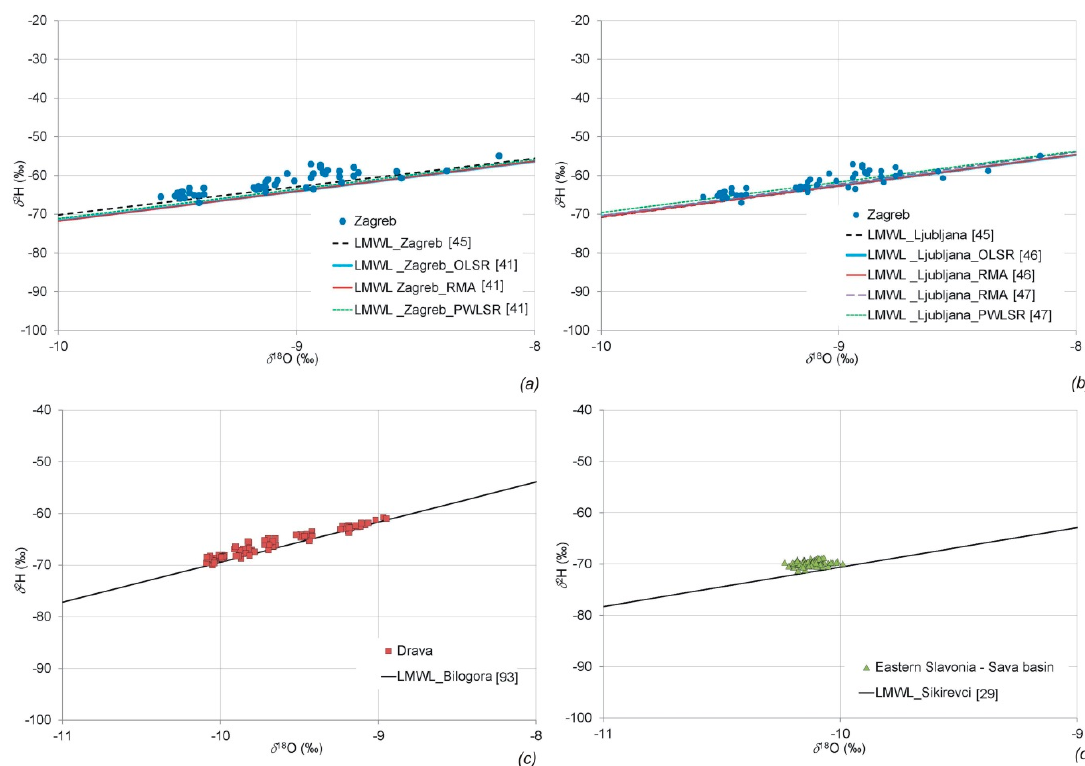
Figure 7. LMWLs and the single stable isotope composition of groundwater in the Pannonian part of Croatia: ( a ) groundwater in the Zagreb aquifer and LMWL Zagreb, ( b ) groundwater in the Zagreb aquifer and LMWL Ljubljana, ( c ) the Drava Basin, and ( d ) Eastern Slavonia—the Sava basin.